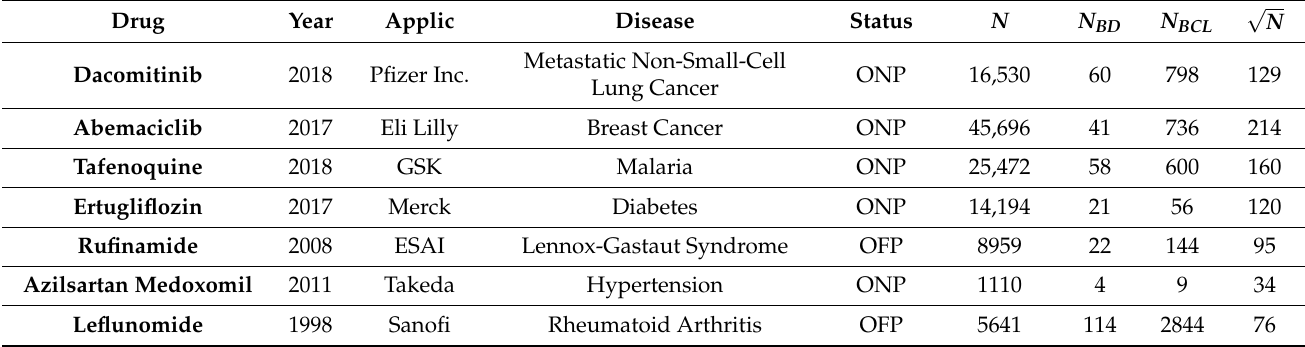
Table 1. Information related to drugs under study. The year of approval (Year), the name of the patent applicant (Applic), the name of the disease (Disease), the patent status (Status), the number of analogs included in MCL ( N ), in Bibliographical Data ( N BD ) and in Bibliographical Combinatorial Library ( N BCL ) and the root square of N